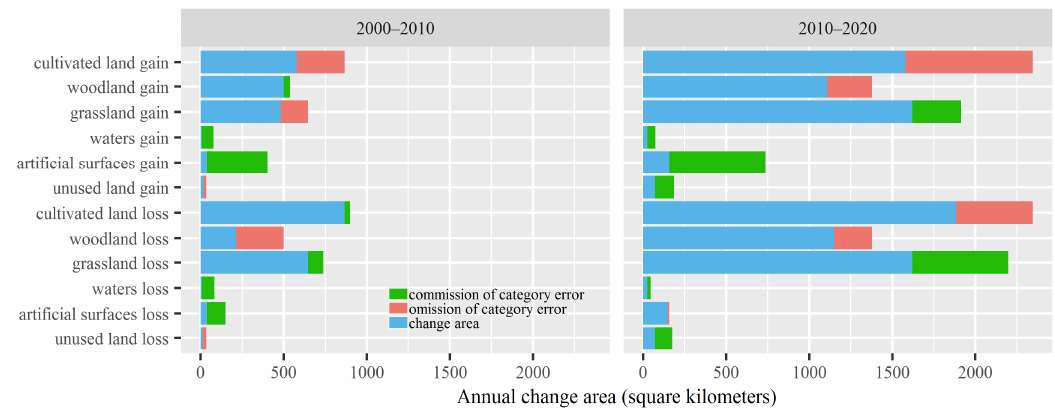
Figure 7. Category level change sizes along with hypothetical errors for the middle reaches of the YRB.